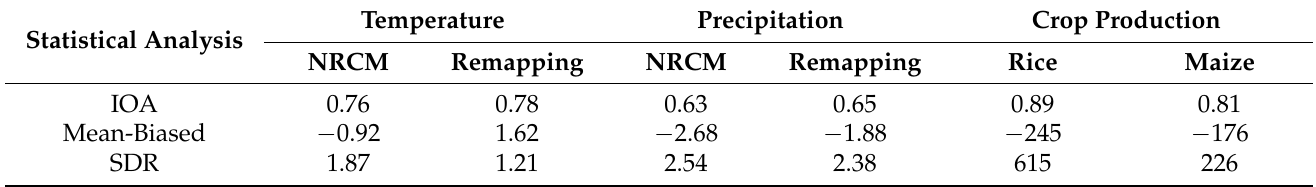
Table 3. Statistical analysis of the model and ground-based observations from the TMD. IOA: index of agreement. Statistical Analysis